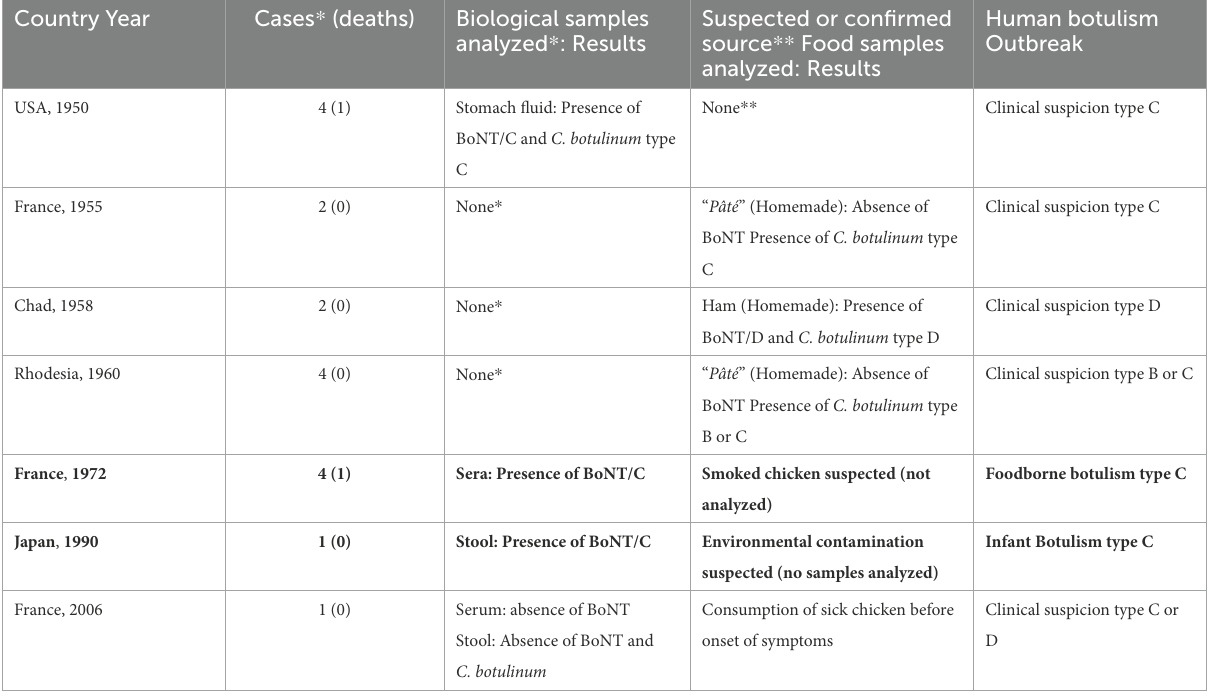
TABLE 5 Zoonotic evidences of toxinotypes C, D, C/D, and D/C